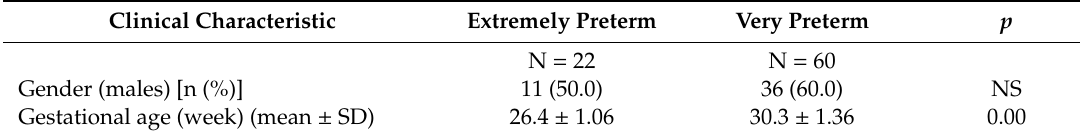
Table 1. Clinical characteristics of the preterm children enrolled in the study. Clinical